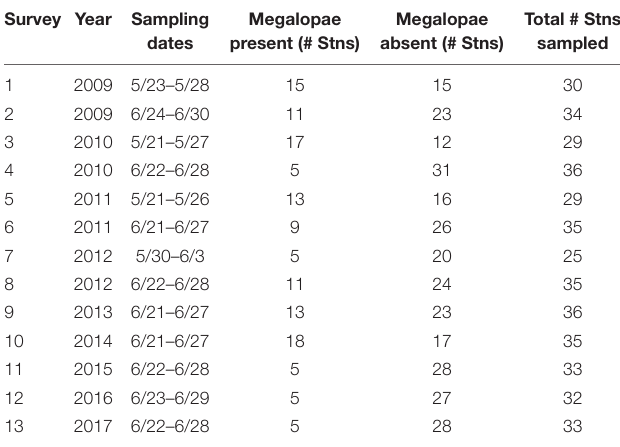
TABLE 1 | Megalopae sampling survey information, including sampling date, number of stations where megalopae were present and absent, and total number of stations sampled (see Figure 4A for map; see Supplementary Table 1 for sampling location information).